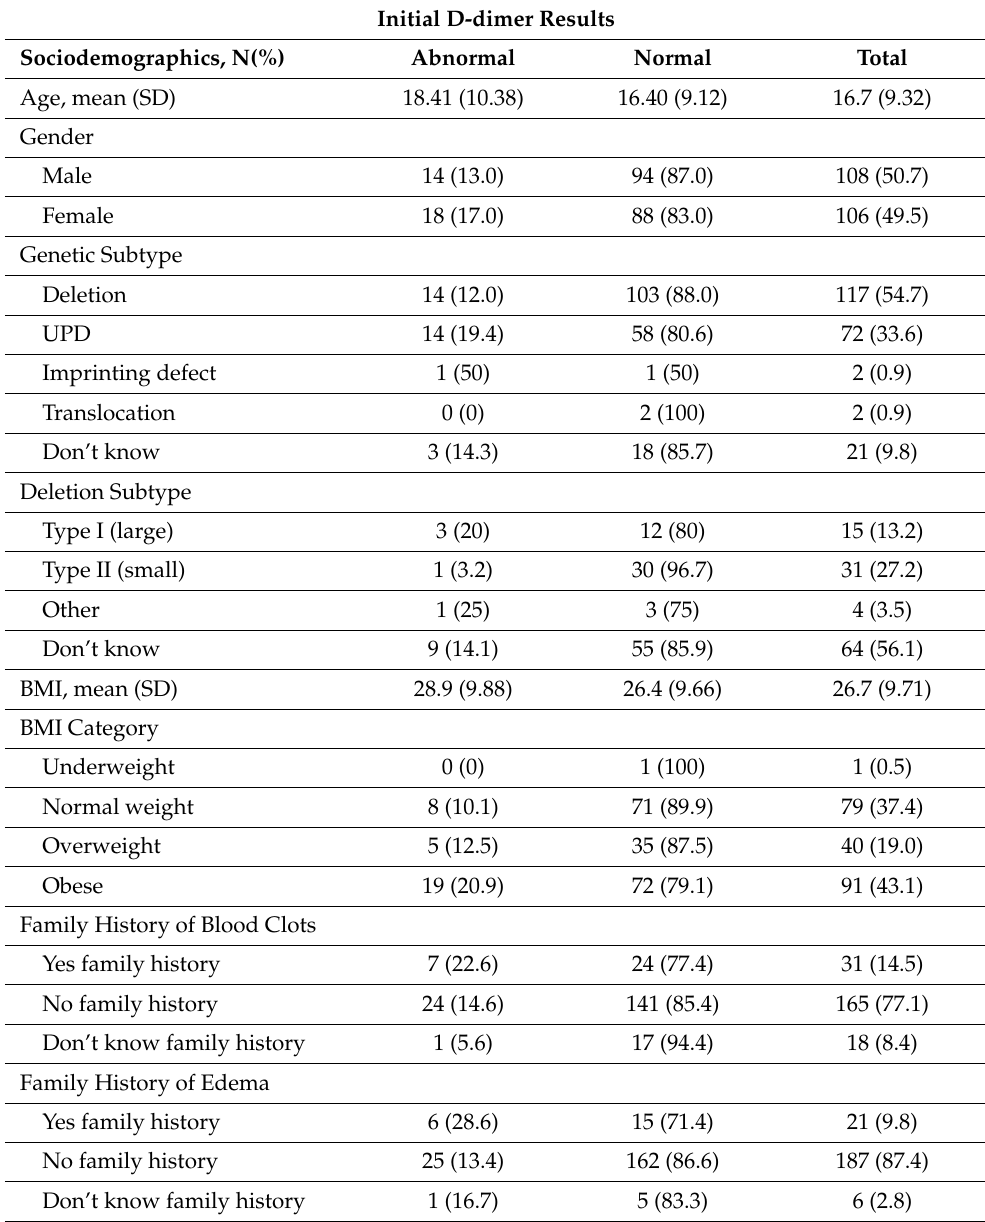
Table 1. Bivariate analysis of D-dimer test results by sociodemographic